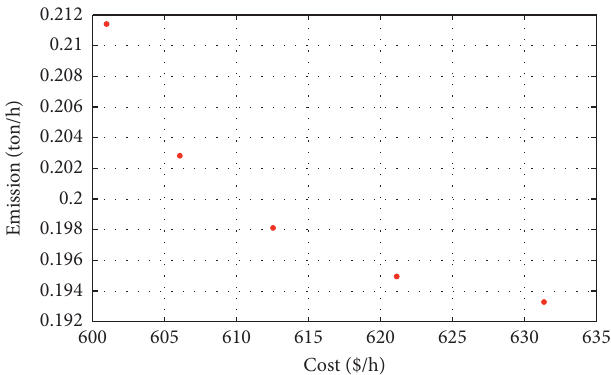
Figure 11: Compromising 5 alternatives from the Pareto